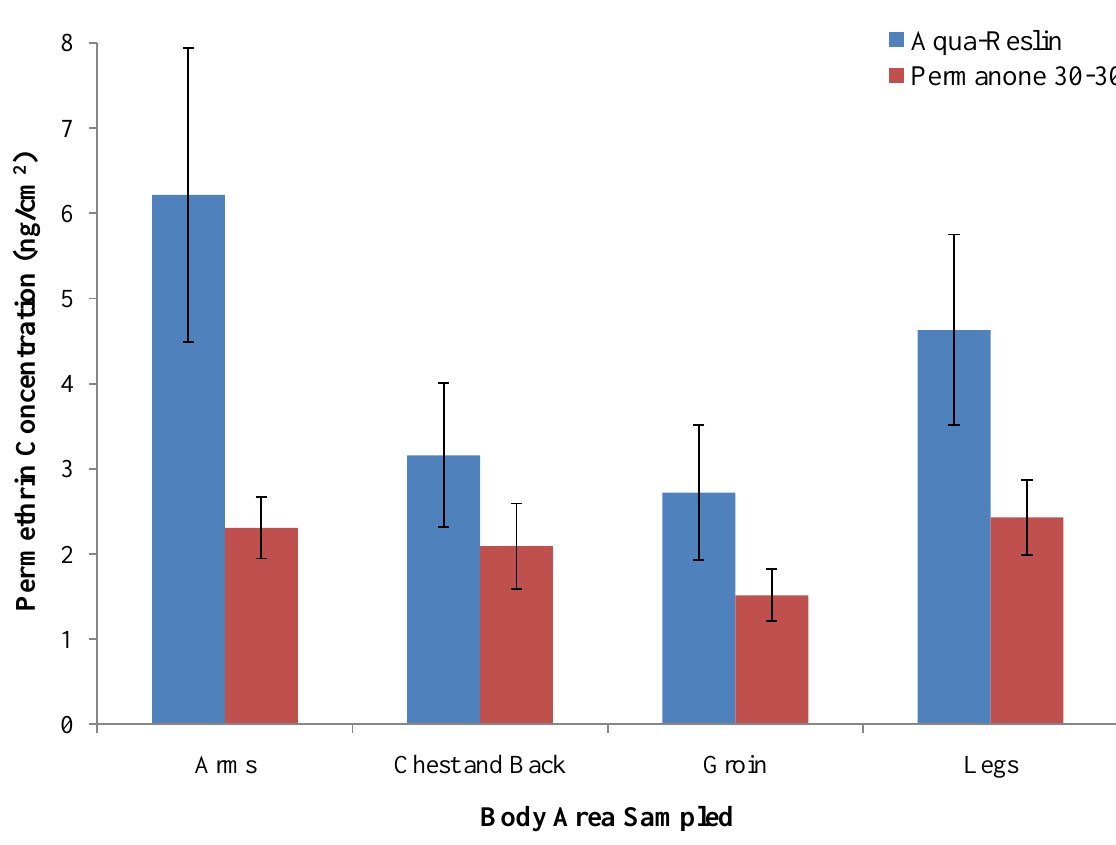
Figure 2. Combined average deposition (±SE) of permethrin for Aqua-Reslin ® and Permanone ® 30-30 on the arms, chest and back, groin, and legs of bystander mannequins 25 and 50 m from the spray source. No significant differences in dermal deposition of permethrin between the front or back of the mannequins or the placement of the patches on the body. Dermal deposition of permethrin from Permanone 30-30 was significantly less than Aqua-Reslin ( p = 0.013).